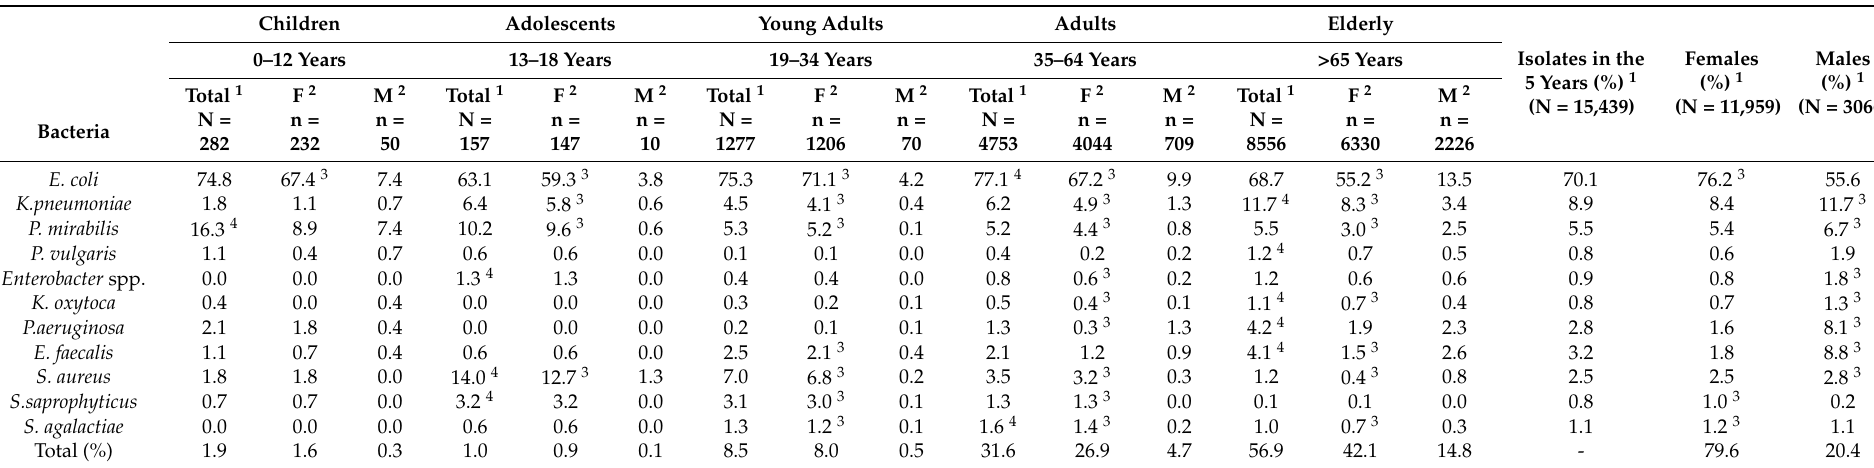
Table 1. Incidence of the main bacteria implicated in urinary tract infections during the study period according to age and